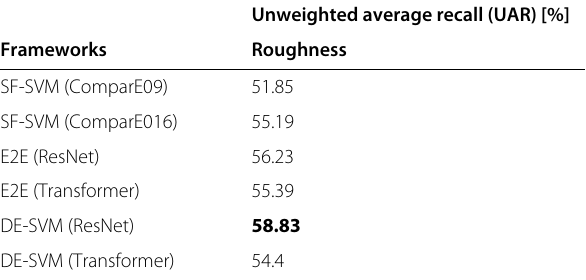
Table 6 Different frameworks’ UAR result for binary classification subtask of